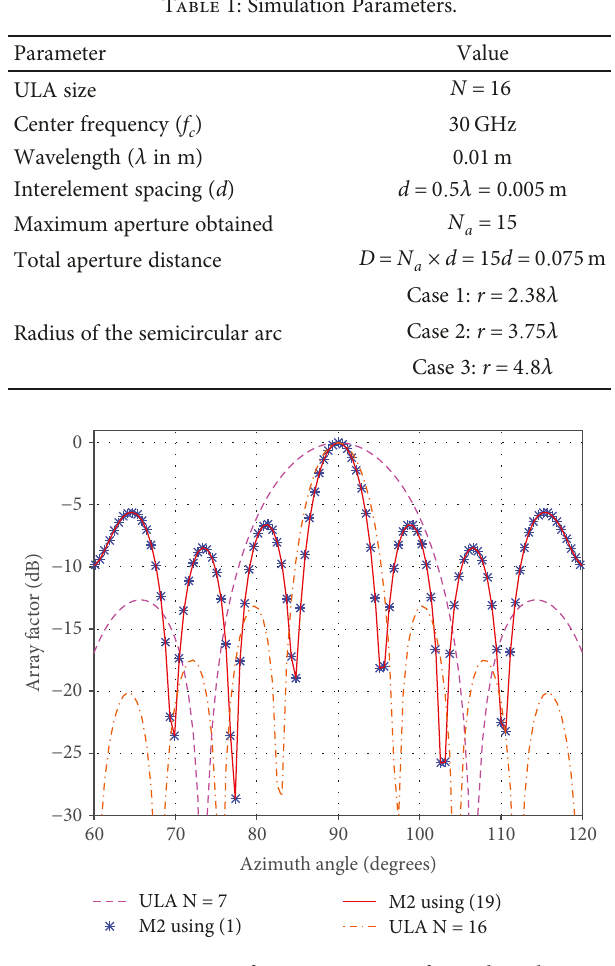
Figure 2: Array patterns of MRA M2, ULAs of 7- and